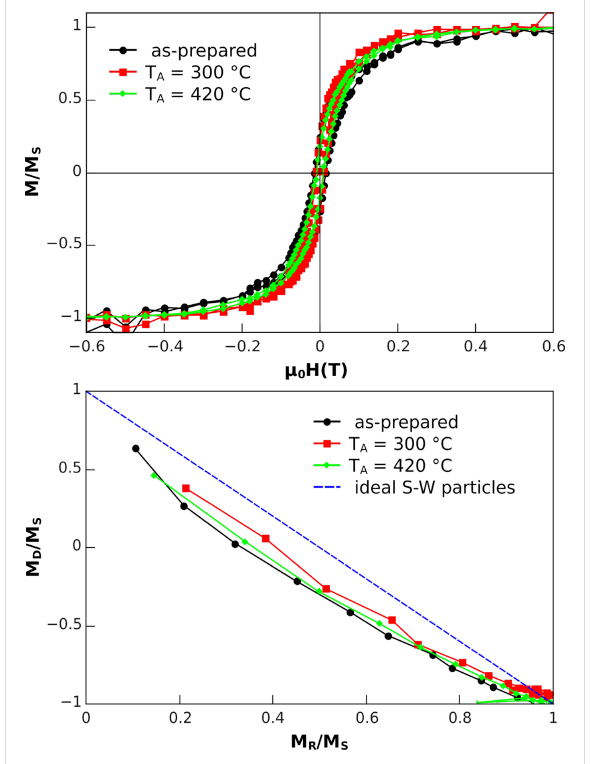
Figure 6: (a) In-plane hysteresis loops measured by SQUID magne- tometry at T = 29 K, i.e., close to the compensation temperature of the diamagnetic MgO substrate and the paramagnetic Pt(111) film on top. In (b), the Henkel plots for three annealing steps are presented. The data of the as-prepared state was taken from [11]. Details are discussed in the